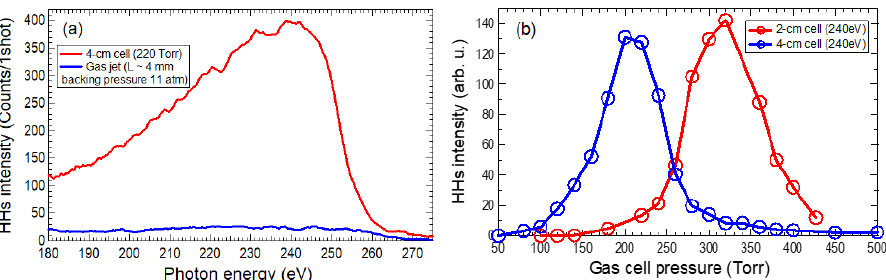
Fig. 3. HH spectra from neon (a). Dependence of a HH intensity at 240 eV as a function of a pressure in a gas cell